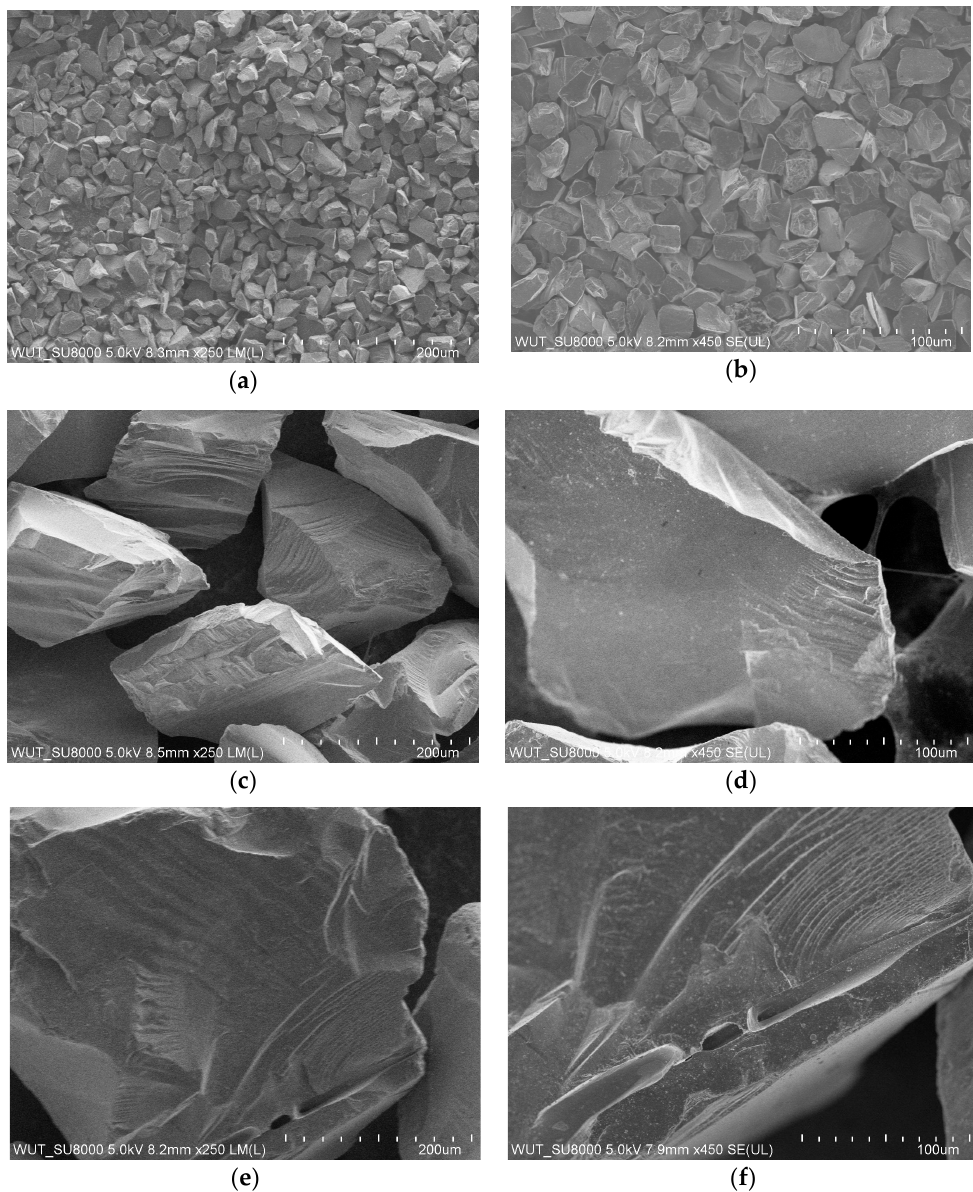
Figure 3. SEM morphologies of powder particles used to fabricate sample shell molds: ( a ) SiC F400: ×250; ( b ) SiC F400: ×450; ( c ) SiC F80: ×250; ( d ) SiC F80: ×450; ( e ) SiC F40: ×250; ( f ) SiC: ×450.